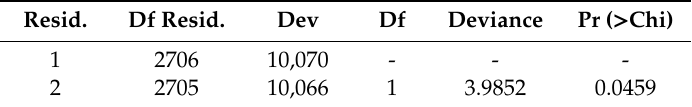
Table 12. Comparison of variables camera type and rotation by ANOVA.